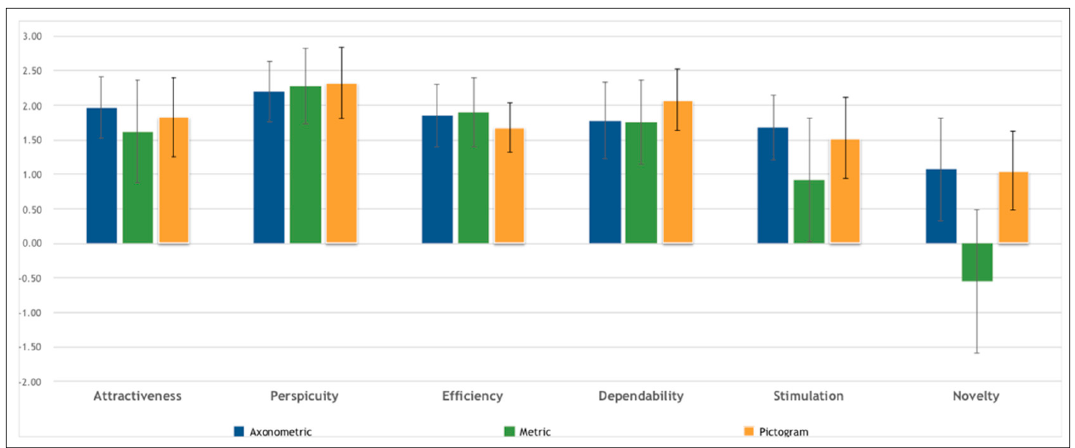
Figure 20. User experience results for each user experience (UX) category and condition. The black error bars indicate the confidence level.